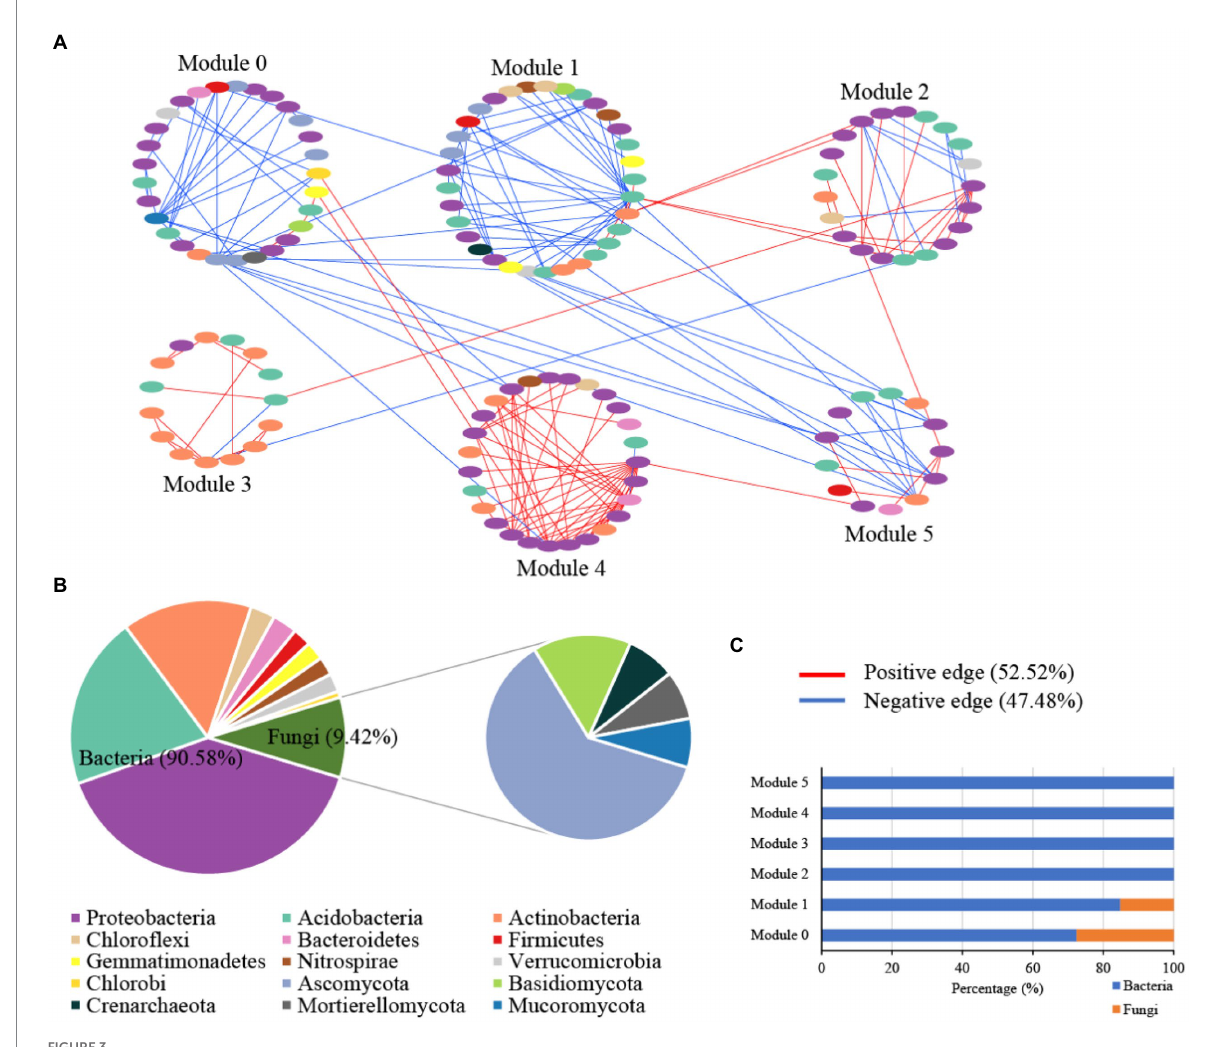
FIGURE 3 The microbial networks of bacterial and fungal communities of Zhanyi Karst Tiankeng Group by modules (A) ; The proportion of microbial composition (phylum level) in main module (B) ; The proportion of bacterial ASVs and fungal OTUs in main module (C)